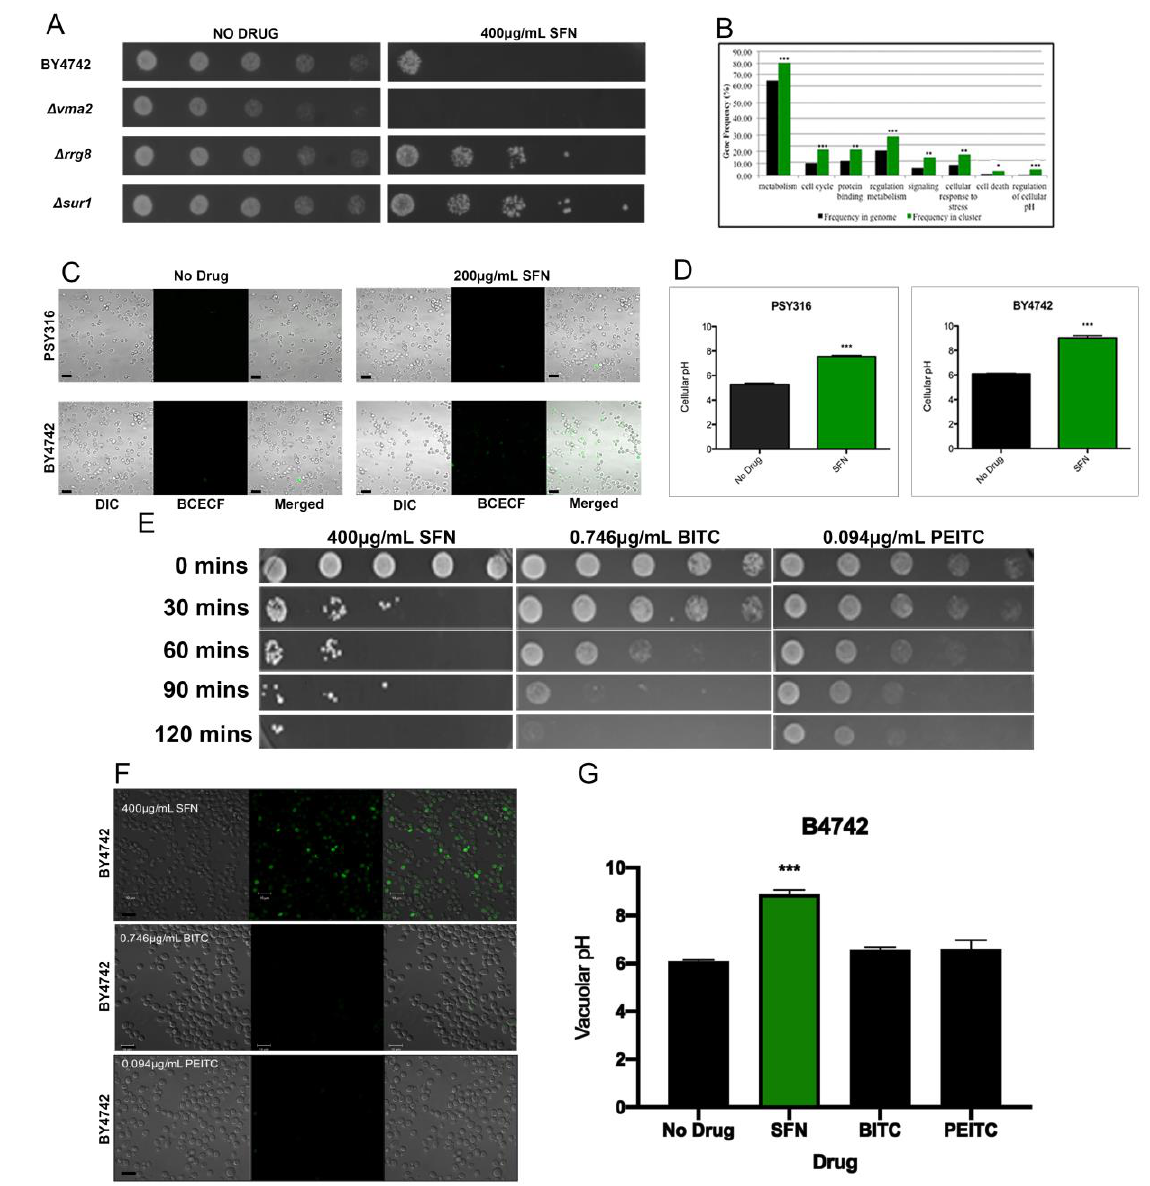
FIGURE 2: SFN alters the acidification of the yeast vacuole. (A) Ten-fold serial dilutions of wild type yeast cells from the BY4742 strain background and of repre- sentative mutant strains that were either SFN S or SFN R were plated on synthetic defined (SD) media with 400 µg/mL SFN, and allowed to grow at 30°C for two days. Deletions in genes known to increase vacuolar pH ( VMA2) increased the sensitivity of cells to SFN, while deletions in genes known to decrease vacuolar pH ( RRG8 and SUR1 ) increased the resistance of cells to the drug. (B) Functional annotation utilizing gene ontology (GO) terms revealed that our screen had preferen- tially isolated mutants in genes involved in vacuolar function, especially in vacuolar acidification and/or pH regulation. Asterisks indicate statistical significance of the enrichment of ORFs identified in the screen as compared to their representation in the genome (* p<0.05; ** p<0.01; *** p<0.001). (C) Wild type cells from the PSY316 and the BY4742 strain backgrounds were grown in SD liquid cultures with and without 200 μ g/mL of SFN, and were stained with the vacuole specific, pH-sensitive dye, BCECF-AM. Cells grown in SFN were significantly more fluorescent than their counterparts grown in media without drug. (D) The vacuolar pH of the cells imaged in Figure 2C was estimated from a calibration curve that plotted the vacuolar pH of fields of cells grown in APG media titrated to different pH values against the fluorescence intensities measured by the LSM700. Error bars indicate standard deviations for trials with at least three independent cultures. The difference in viabilities was deemed statistically significant by the Student’s t -test comparing cells grown in SFN with control cells grown without drug (*** p<0.001). Scale bars indicate a width of 10 µm. (E) 10-fold serial dilutions of wild type yeast cells from the BY4742 strain background cultured in synthetic defined liquid cultures containing the indicated drugs for the indicated time periods (BITC=0.746 µg/mL, PEITC=0.094 µg/mL, SFN=400 µg/mL), were plated on SD media and allowed to grow at 30°C for two days. (F) Wild type cells from the BY4742 strain background were grown in SD liquid cultures containing the indicated drugs for two hours and were stained with the vacuole specific, pH-sensitive dye, BCECF-AM. Cells grown in SFN were fluorescent while their counterparts grown in media with the other drugs were not. Scale bars indicate a width of 10 µm. (G) The vacuolar pH of the cells imaged in Figure 2F was estimated from a calibration curve that plotted the vacuolar pH of cells grown in APG media titrated to different pH values against the fluorescence intensities measured by the LSM700. Error bars indicate standard deviations for trials with at least three independent cultures. The difference in viabilities was deemed statistically significant by the Stu- dent’s t -test comparing cells grown with the indicated drug with control cells grown without the drug (***